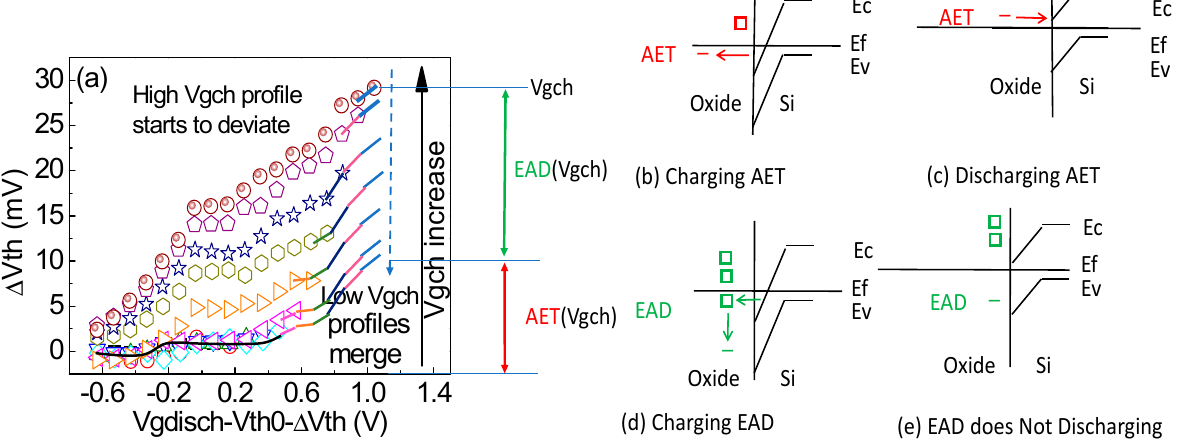
Figure 44. ( a ) Tests for separating as-grown electron traps (AETs) from the as-grown energy- alternating defects (EADs) [39]. ( b ) When an AET is below Ef, it is charged. ( c ) The energy levels of the AETs did not change after charging. It was discharged when above the same Ef for its charging. ( d ) When an EAD is below Ef, it is charged. After charging, the energy level of the EAD is lowered, so that it will not be discharged under the same Ef for its charging in ( e